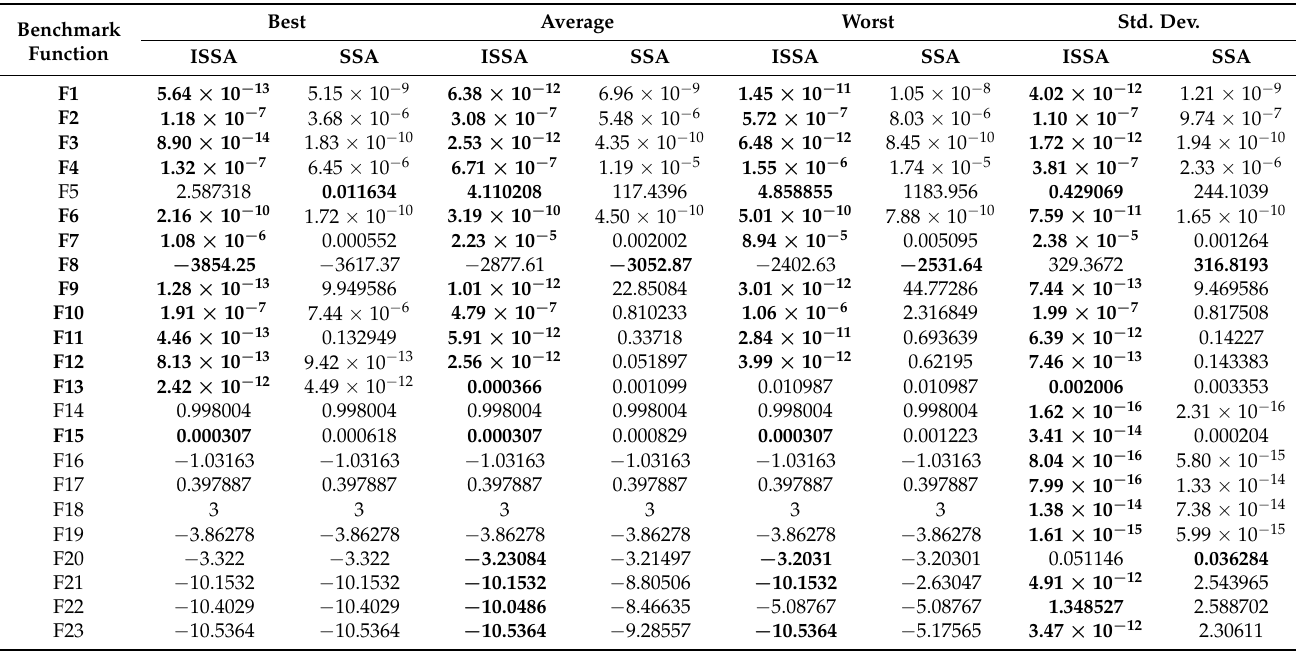
Table 2. Results of SSA and ISSA on the benchmark test functions.